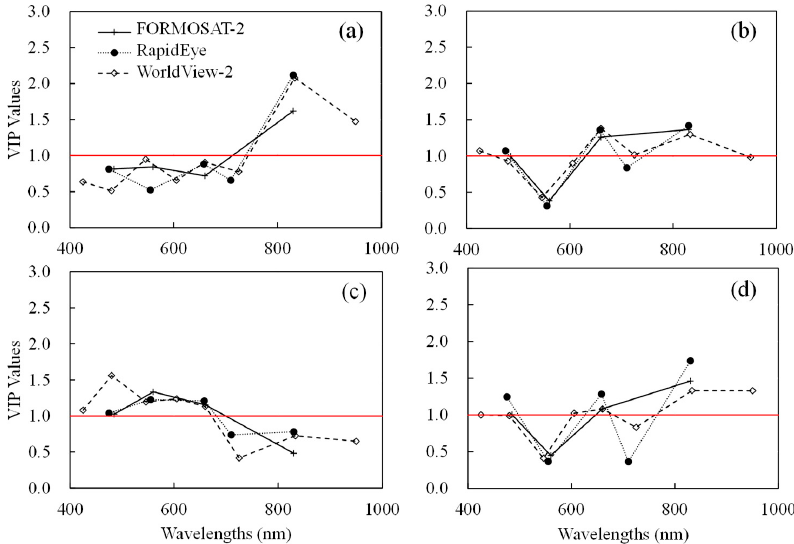
Figure 4. Variable Importance in Projection (VIP) values as function of wavelengths formatted to FORMOSAT-2, RapidEye, and WorldView-2 spectra for aboveground biomass (AGB) estimation at: the panicle initiation (PI) ( a ); stem elongation (SE) ( b ); heading (HE) ( c ); and across stages ( d ).